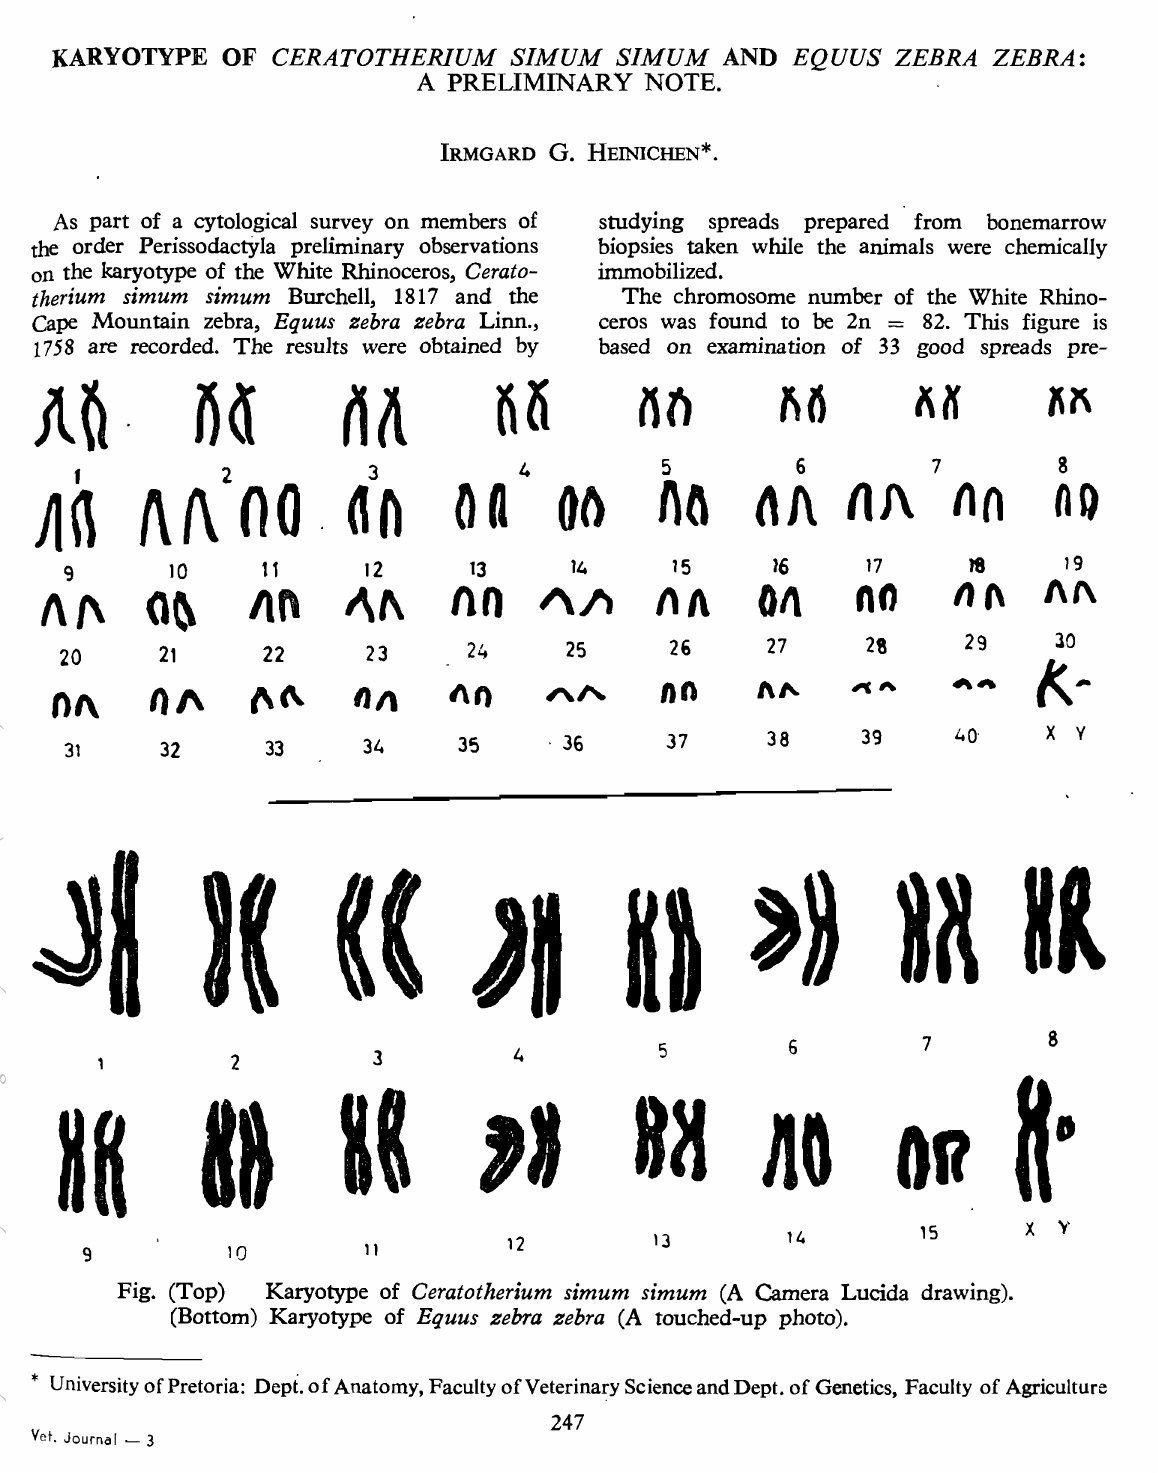
Fig. (Top) Karyotype of Ceratotherium simum simum (A Camera Lucida drawing). (Bottom) Karyotype of Equus zebra zebra (A touched-up